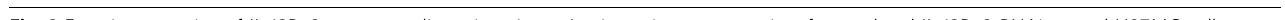
Fig. 2 Ectopic expression of IL-13R α 2 promotes glioma invasion. a In vitro migratory capacity of control and IL-13R α 2-RNAi treated U87MG cells was determined. Percent of migrated cells was normalized to CTRL-RNAi. b U87MG cells were transfected with non-speci fi c siRNA (CTRL-RNAi) or IL- 13R α 2 speci fi c siRNA (IL-13R α 2-RNAi). Cell proliferation was subsequently determined, and the percent of proliferation was normalized to CTRL-RNAi day 1. c In vitro migratory capacity of control and IL-13R α 2-RNAi treated U87MG cells, stimulated with 1 µ g ml − 1 YKL40 or 20 ng ml − 1 IL-13 for 18 h, was determined using wound-healing migration assay. All data are represented as mean ± SEM. Unpaired t -test * p < 0.05; *** p < 0.001; NS not signi fi cant. d Immunoblotting experiment showing upregulation of MMP-2, and vimentin in Gli36.IL-13R α 2 cells. Densitometry quanti fi cation was done for the indicated proteins by normalizing to pan-actin as the internal loading control. Ratios were indicated below each blot. e Mice were implanted with either Gli36-GFP or Gli36.IL-13R α 2-GFP cells intracranially. Tumors were collected from representative mice implanted with Gli36.IL-13R α 2-GFP showed the invasive phenotype (left panel) when compared to the contralateral normal brain parenchyma (right panel) by haematoxylin and eosin (H&E) staining. Red arrows indicated glioma tumor at the invasive front f Representative images of mouse brain transplanted with Gli36- GFP cells and Gli36-IL-13R α 2-GFP, counterstained with DAPI (blue). The top panel shows the contralateral hemisphere; bottom panel shows tumor-bearing hemisphere of the mouse brain (N, normal; T, tumor). Scale bar, 50 μ m. g Immuno fl uorescence red staining of MMP-2, vimentin or isotypic control in mice bearing either Gli36.IL-13R α 2- GFP or Gli36-GFP. Scale bar, 50 μ m. h Kaplan − Meier survival curves of mice bearing Gli36 and Gli36.IL-13R α 2 tumors. NS not signi fi